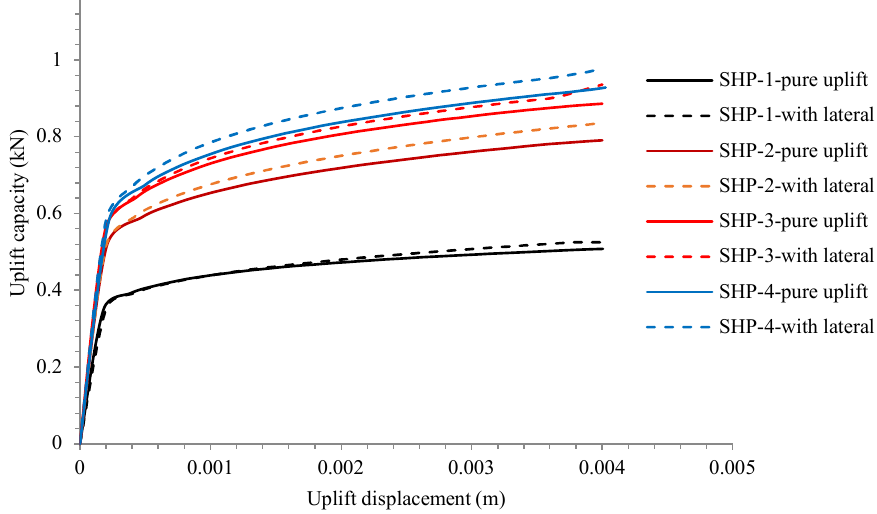
Figure 17. Effect of lateral loading on uplift capacity of helical pile.